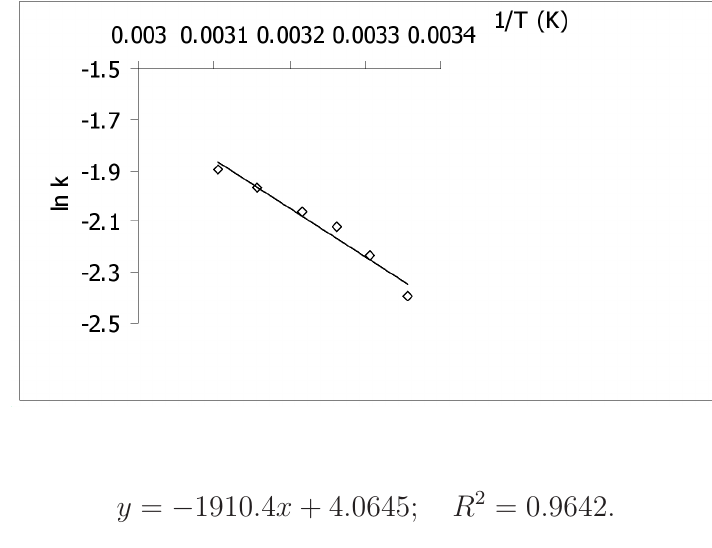
Fig. 8 ln k versus 1 /T for